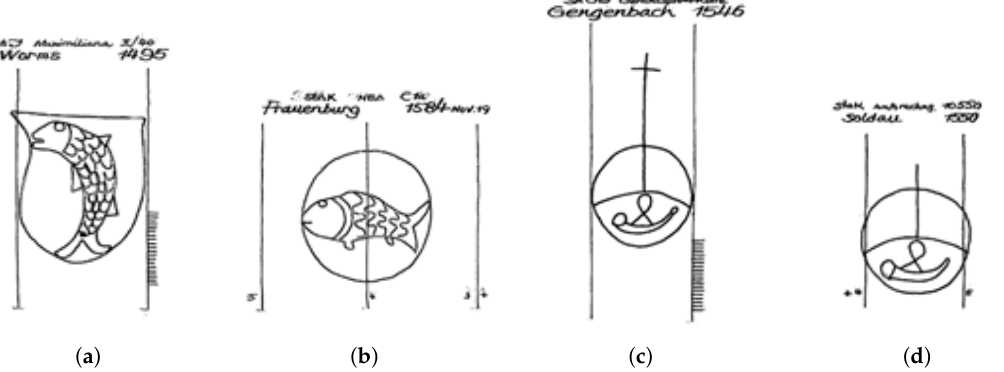
Figure 4. Two examples of an issue caused by the mono-hierarchical tree structure used for classification of the different watermarks (see Section 3.2). Note how sample ( a ) is classified in the superclass “Coat of Arms” and sample ( b ) is classified in the superclass “Fauna” despite looking very similar. This effect can also be observed between samples ( c , d ) which despite their similarity, get assigned to two different super-classes. ( a ) Fish on coat of arms. Assigned to coat of arms superclass; ( b ) Fish in a circle. Assigned to fauna superclass; ( c ) Horn in a circle with a cross. Assigned to artefacts superclass; ( d ) Horn in circle. Assigned to geometrical figures